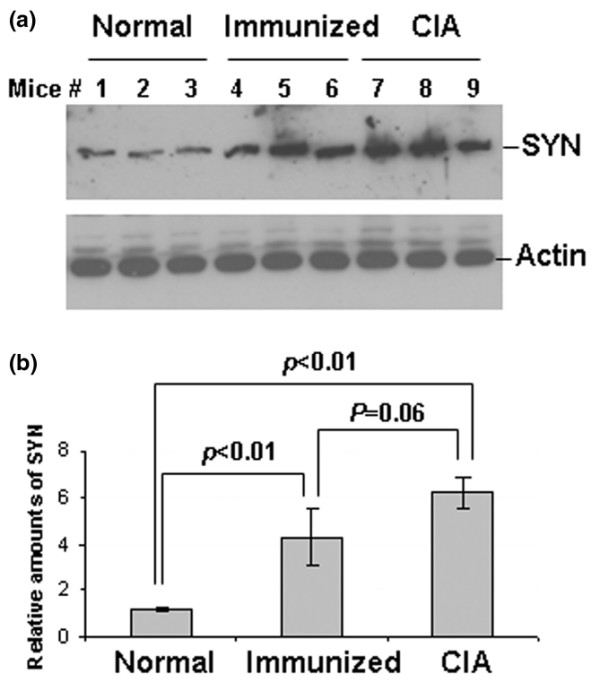
The expression of Synoviolin (SYN) during collagen-induced arthritis (CIA) development. (a) Synovial fibroblasts were isolated from normal DBA mice (Normal) and DBA mice 20 days after the first collagen immunization (Immunized) or 10 days after the second immunization when CIA is developed (CIA). The expression of SYN in those synovial fibroblasts was analyzed by Western blotting. (b) The densities of each band in (a) were analyzed, and the ratio of SYN/(10-1 actin) was used. Error bars represent three different CIA, immunized, or normal mice. Statistic analysis indicates that the expression of SYN is significantly increased during CIA development.